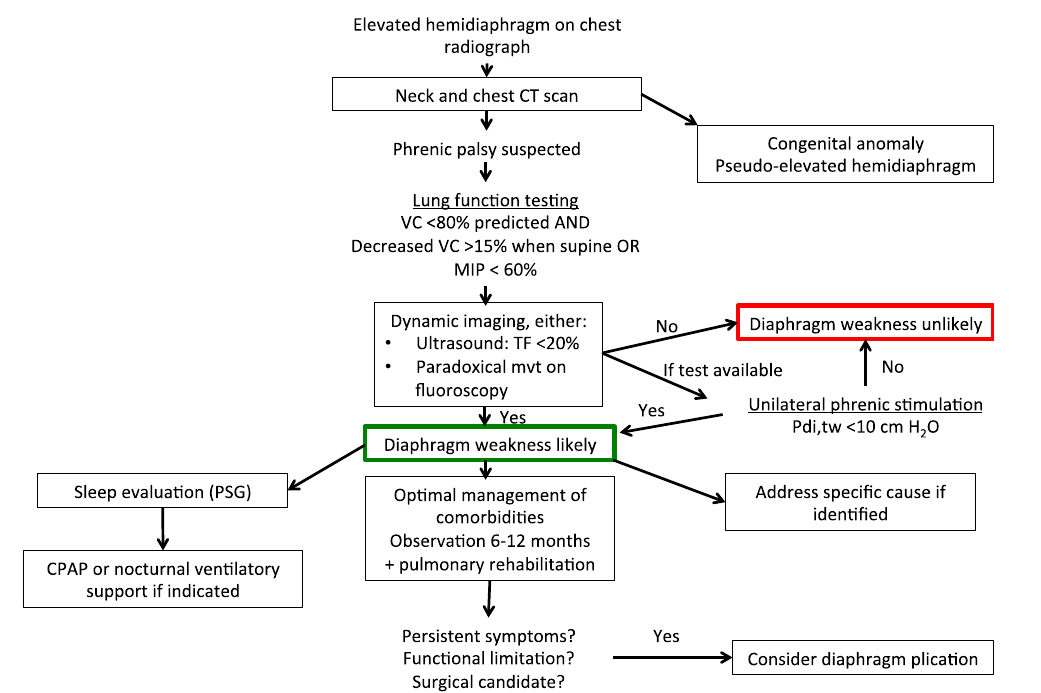
Figure 1. Suggested diagnostic and therapeutic algorithm for unilateral diaphragm weakness. CT, computed tomography; VC, vital capacity; MIP, maximal inspiratory pressure; TF, thickening fraction of the diaphragm; PSG, polysomnography; CPAP, continuous positive airway pressure; Pdi,tw, twitch transdiaphragmatic pressure.